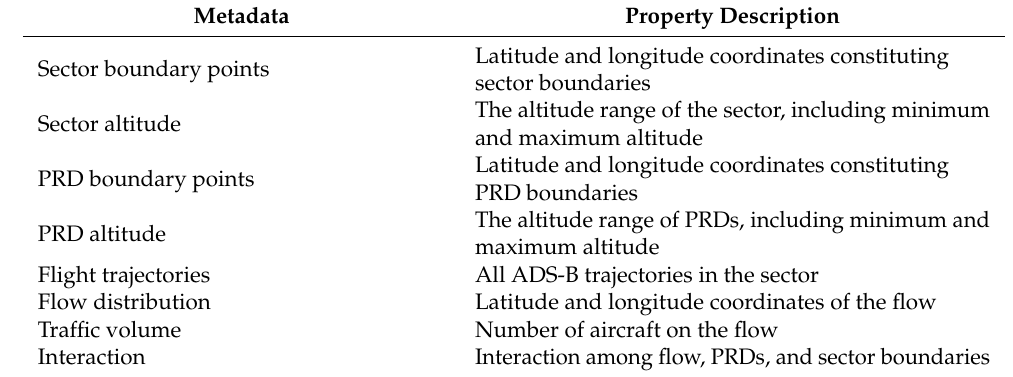
Table 1. Metadata of control sector.